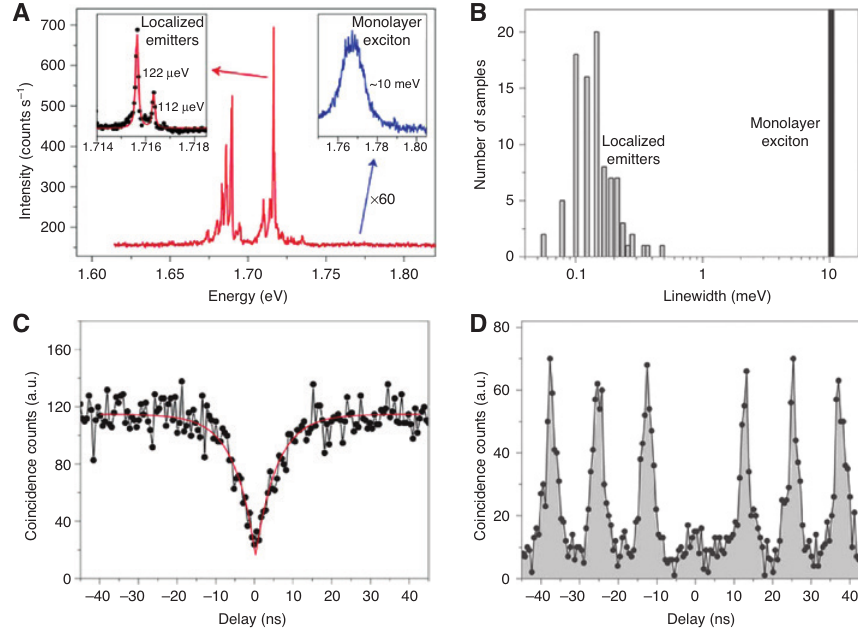
Figure 7: Emergence of narrow spectral lines and observation of photon antibunching, taken from Ref. [75]. (A) PL spectrum of localized emitters. The left inset is a high-resolution spectrum of the highest intensity peak (single quantum emitter). The right inset is a zoom-in of the SL valley exciton emission, integrated for 60 seconds. The emission of the localized emitters exhibits a red shift and much sharper spectral lines. (B) A histogram comparison of the linewidth between the emission from the delocalized valley exciton and 92 localized emitters, grouped in 23.3 μ eV bins. (C) Second-order correlation measurement of the PL from SQE under a 6.8 μ W CW laser excitation at 637 nm. The red line is a fit to the data, from which we extract g 2 (0) = 0.14 ± 0.04. (D) Intensity correlation measurement under 9.5 μ W (average) pulsed excitation at 696.3 nm with a repetition rate of 82 MHz, and a pulse width of ~ 3 ps, which revealed g 2 (0) = 0.21 ±